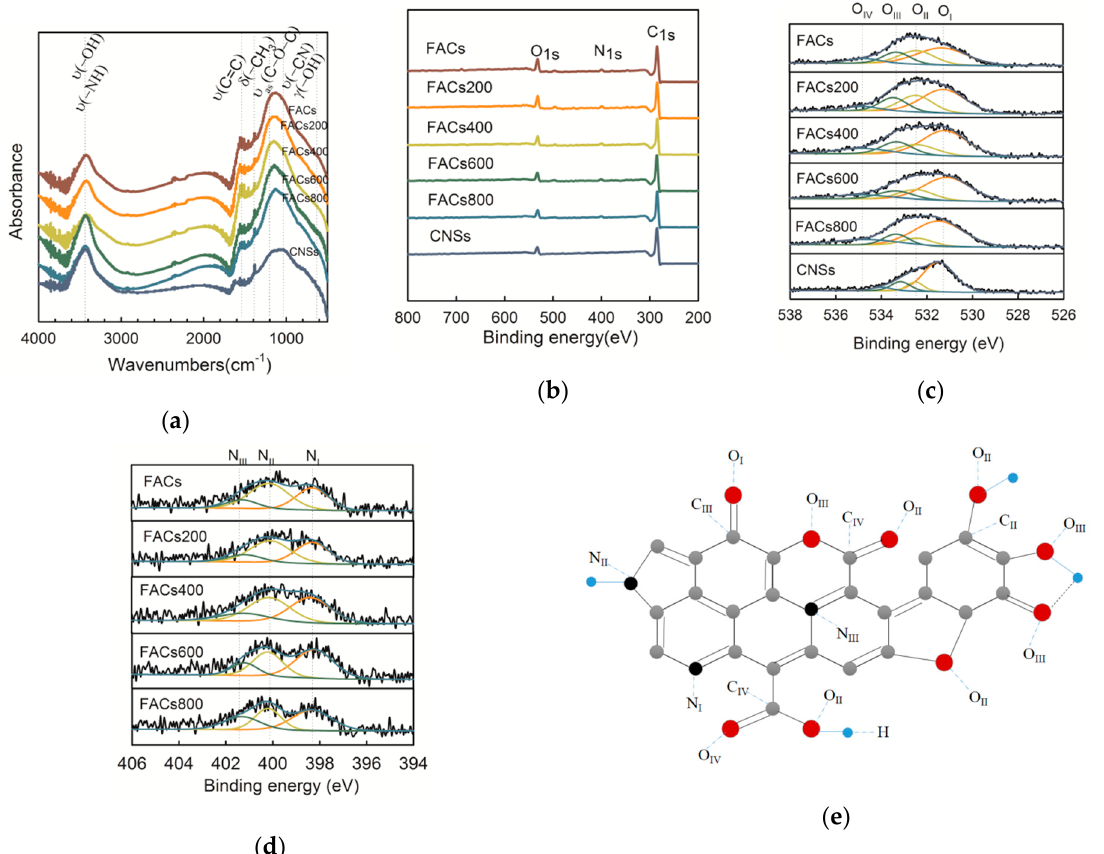
Figure 3. ( a ) FTIR spectra of six samples. υ , stretching; δ , bending (in-plane); γ , bending (out-of-plane); s, symmetric; as, asymmetric. ( b ) Experimental X-ray photoelectron spectroscopy (XPS) results of the six samples. ( c ) Comparison of the O1s deconvolutions for the six samples. ( d ) Comparison of the N1s deconvolutions for the five samples. ( e ) Schematic diagram of the FACs chemical structure.